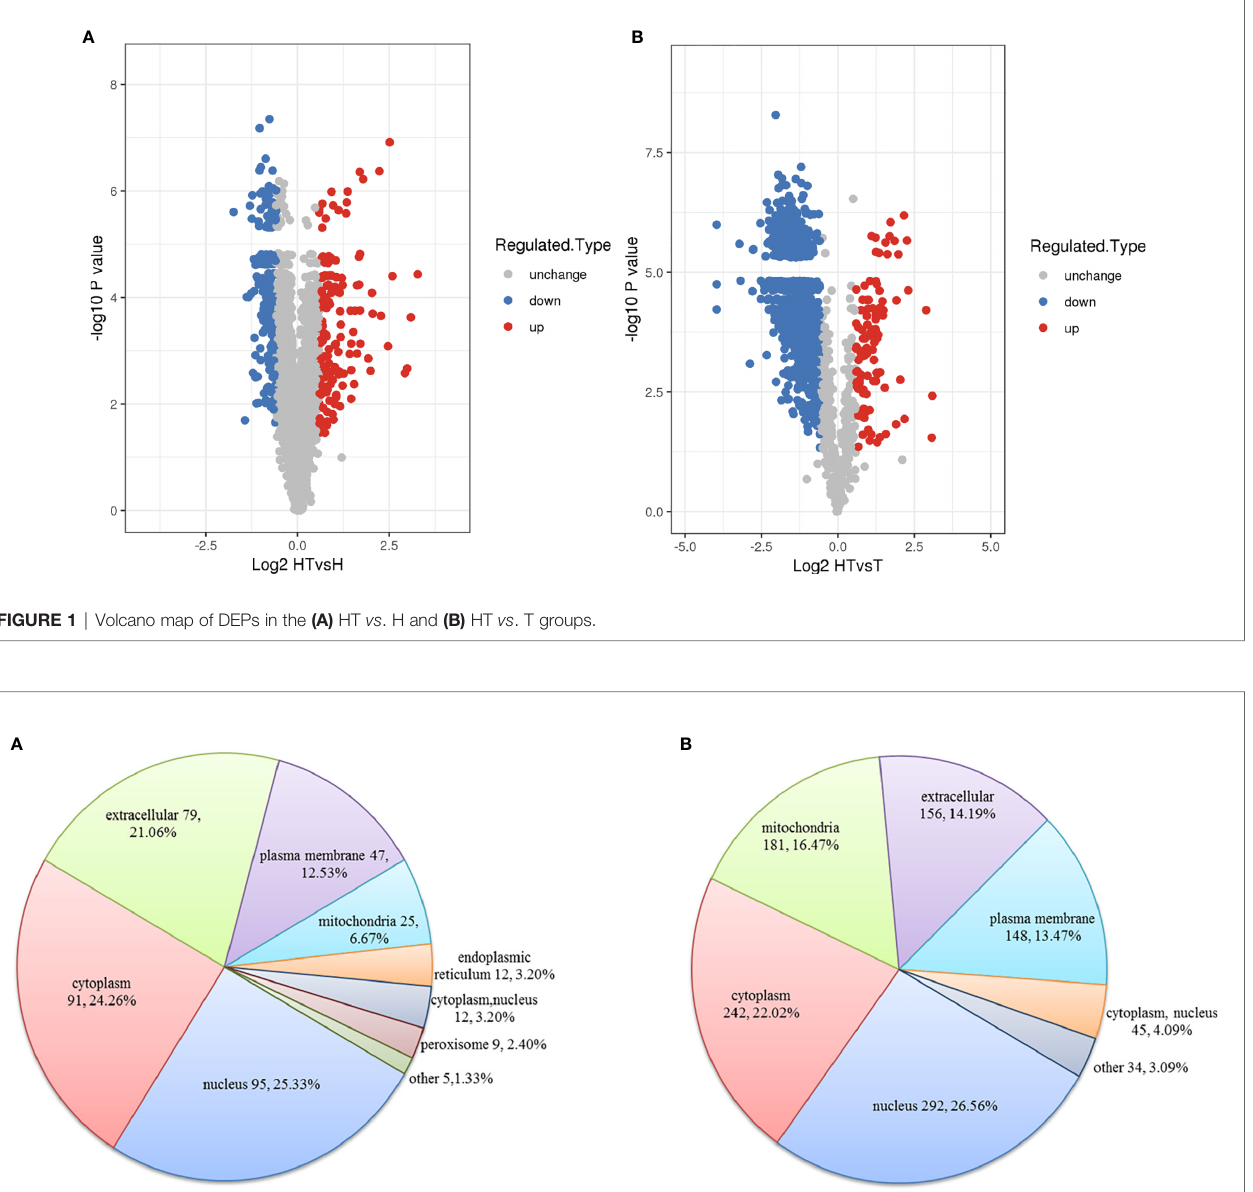
FIGURE 2 | Subcellular location of DEPs in the (A) HT vs . H and (B) HT vs . T groups. Numbers represent the number of